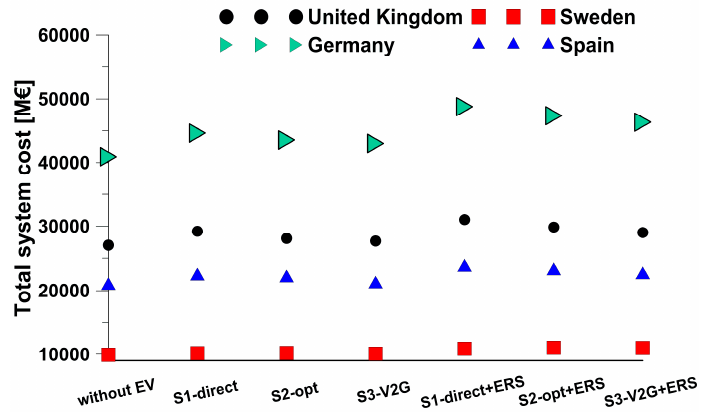
Figure 9. The total system costs for the different countries and scenarios, as derived from the cost-optimisation investment model (ELIN).